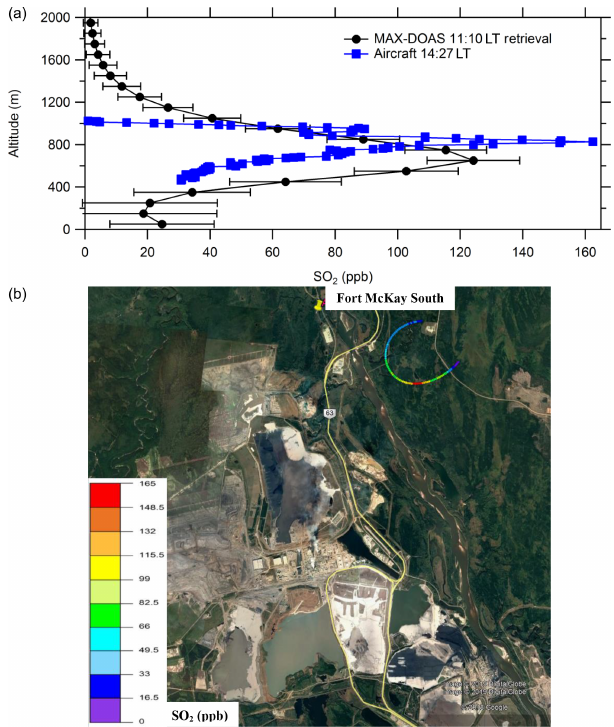
Figure 20. The 3 September vertical profiles of SO 2 (ppb) from an aircraft spiral measurement (14:26–14:28LT) and MAX-DOAS retrieved SO 2 vertical profile (11:10LT). Aircraft spiral is shown in a Google Earth plot (b)